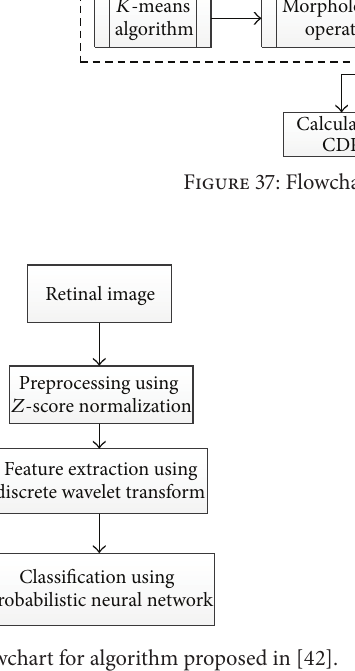
Figure 38: Flowchart for algorithm proposed in [42].